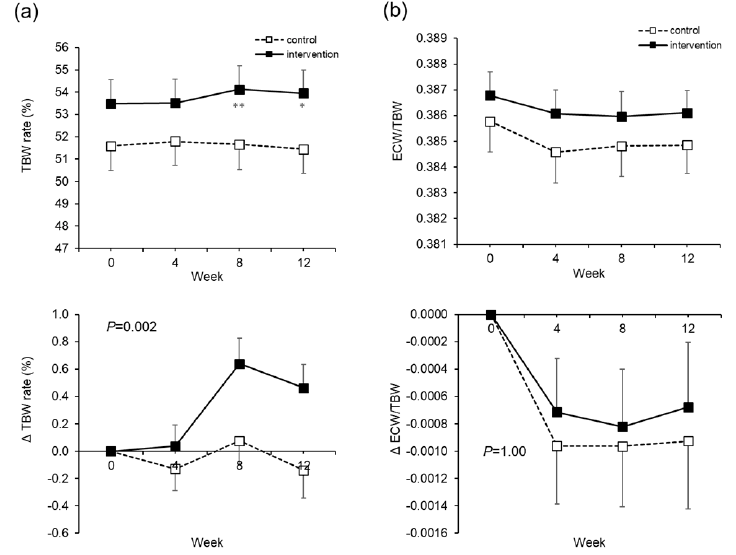
Figure 3. Total body water (TBW) rate and extra-cellular water (ECW)/TBW. The actual level (upper) and changes (lower) in the TBW rates ( a ). The actual level (upper) and changes (lower) in ECW/TBW ( b ). The dotted line is the control group. The solid line is the intervention group. Mean ± SEM. The P value is the difference between the groups for the change from Week 0 to Week 12. Two-way analysis of variance was performed. * Paired t -test adjusted by the Bonferroni method was performed for intragroup comparisons from Week 0. * p < 0.05, ** p < 0.001.